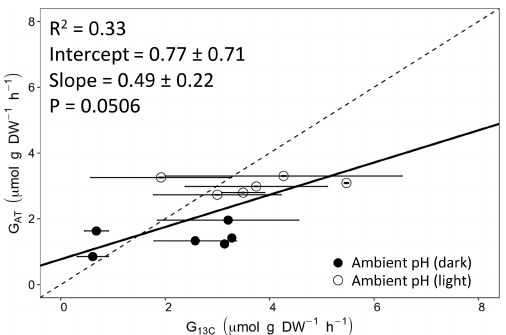
Figure 4. Calcification rates estimated based on the alkalinity anomaly technique ( G A ) as a function of calcification rates esti- T mated based on 13 C incorporation technique ( G 13 ). The dashed C line represents the 1 : 1 relationship while the full line represents the model II regression relationship. Horizontal error bars represent standard errors (SE) associated with the estimation of G 13 . Ver- C tical error bars representing SE associated with the estimation of G A are too small to be visible. The corresponding dataset can be T found in Table